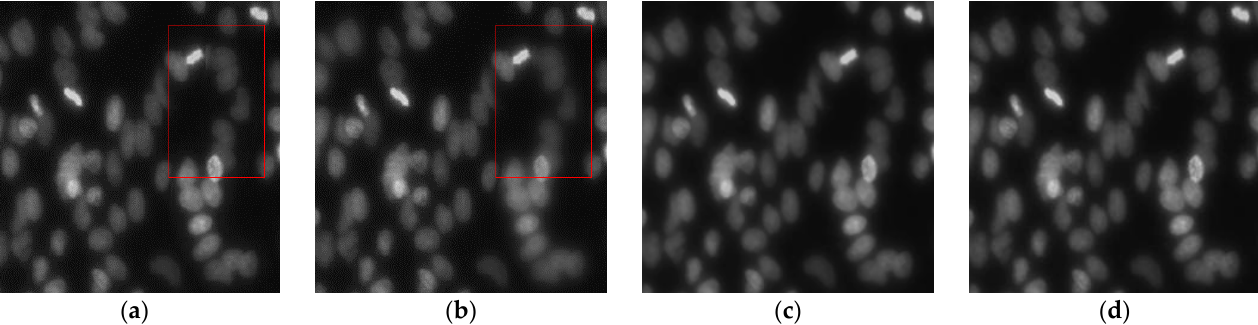
Figure 5. Fused image results generated by different methods. The top row contains the “Dark cell” image set. The bottom row contains the “Bright cell” image set. ( a ) DWT, ( b ) quad-tree, ( c ) GFDF, and the ( d ) proposed method.